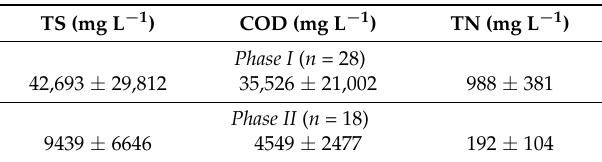
Table 1. Characteristics of raw septage (mean ± standard deviation) in Phase I and Phase II of the